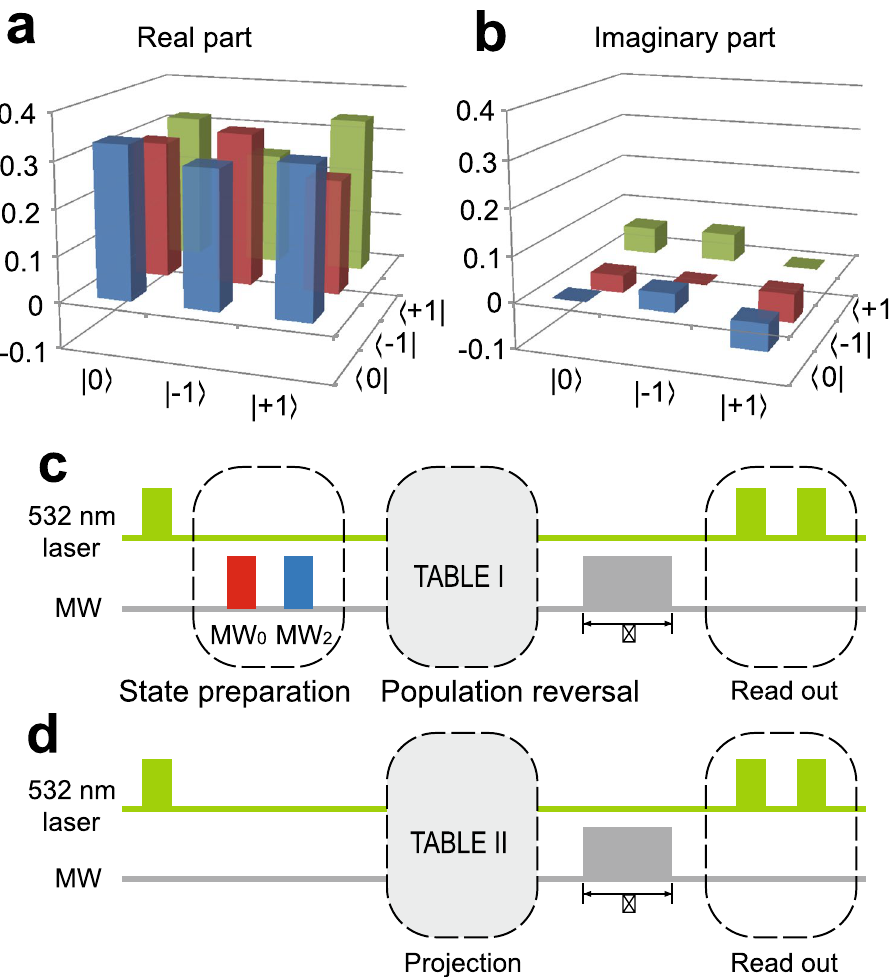
Figure 4. State tomography and pulse sequences for entropy measurement and state tomography. ( a ) Real part of state tomography result of an electron spin superposition state + − + + ( 0 1 1 ) 1 . ( b ) Imaginary part 3 of state tomography result. ( c ) Pulse sequence for state tomography. State preparation is executed by adopting MW 0 with 26 ns and MW 2 with 26 ns. Population reversal is implemented by MW pulses shown in Table 1. ( d ) Pulse sequence for generalized entropic uncertainty relations for multiple measurements. The projection scheme is carried out by MW pulses shown in Table 2. The MW pulse whose length is τ indicates the Rabi oscillation